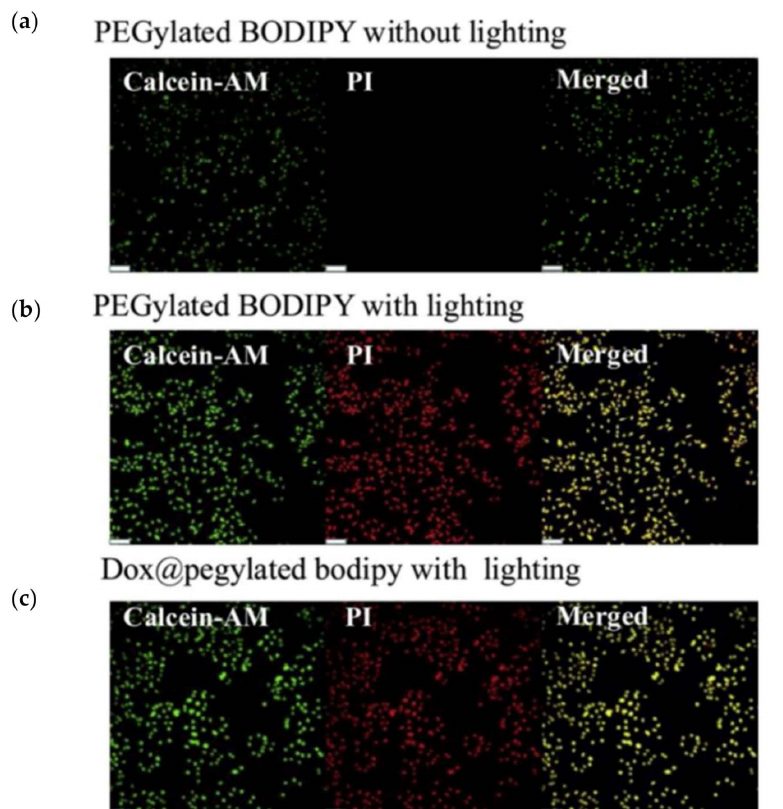
Figure 6. CLSM images of live/dead assay (Calcein-AM/PI) on co-stained MDAMB-231 cells after incubation with ( a ) PEGylated BODIPY without lighting, ( b ) PEGylated BODIPY with lighting, ( c ) Dox@PEGylated BODIPY with lighting. The Calcein-AM has green fluorescence and the PI has red fluorescence. Scale bar was 100 µ m. Adapted from